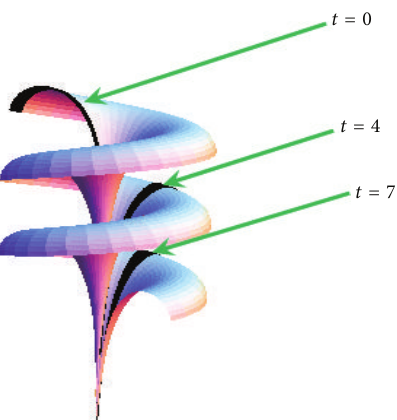
Figure 2: The surface that is generated by the motion of the family of curves 𝐶 𝑡 for 𝑠 ∈ [0,5] , 𝑡 ∈ [0, 8] , 𝑎 = 0.5 , 𝑐 1 = 1 , 𝑐 2 = −0.001 , and = 0 . The bold black curves in this surface represent the family of 𝑐 3 curves 𝐶 𝑡 for 𝑡 = 0, 4,7 .